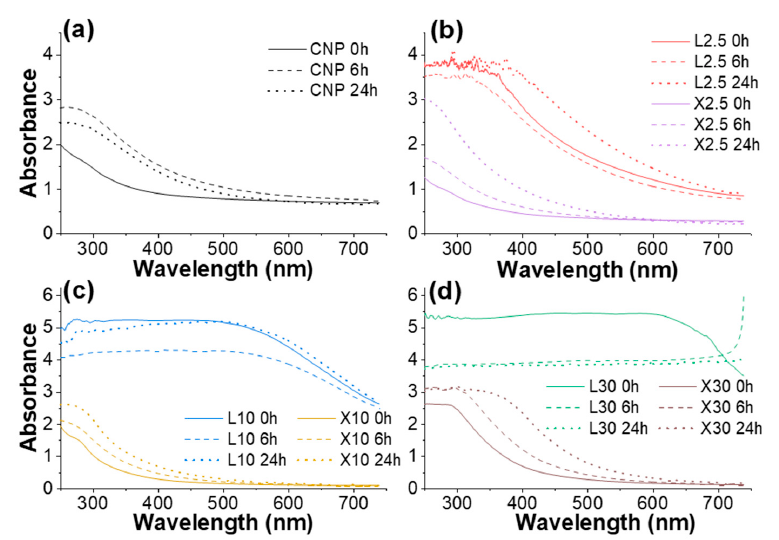
Figure 8. UV ‐ vis spectra of NPs before and after aging 6 h and 24 h: ( a ) CNP, ( b ) L2.5 and X2.5, ( c ) L10 and X10, ( d ) L30 and X30.